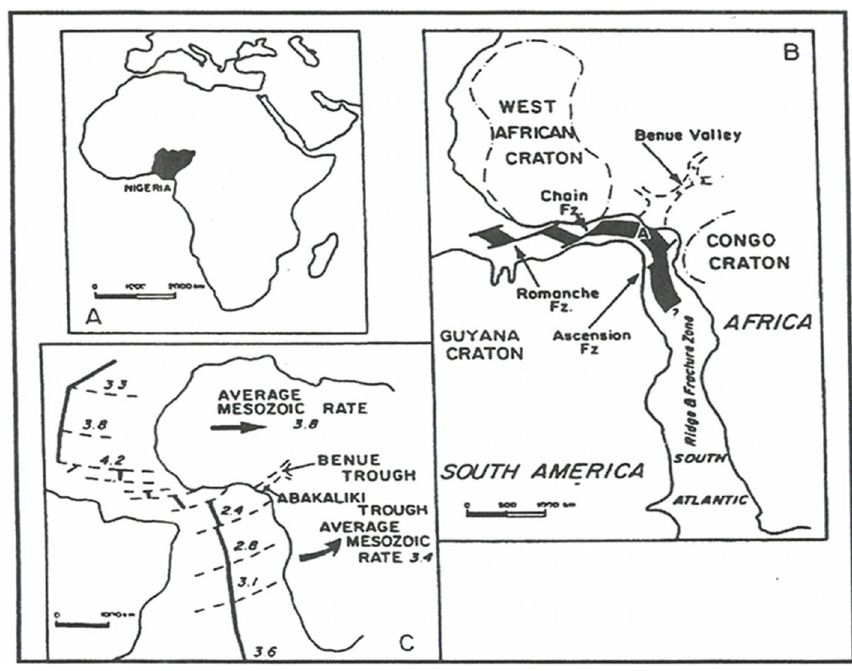
Fig. 2 A Location of Nigeria. B Early cretaceous separation of Africa and South America showing the proposed Niger Delta Triple Junction. C Map showing Mesozoic spreading rates (cm/year) for Africa-South American separation